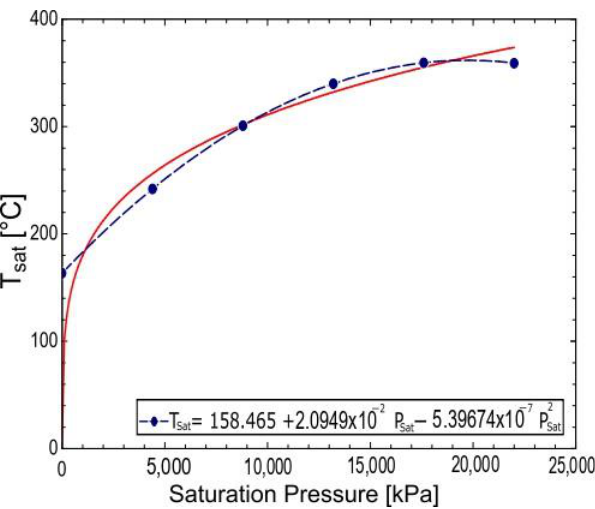
Figure 8. Graph used to determine the saturation temperature polynomial using linear regression (curve fitting) in the EES ® software.